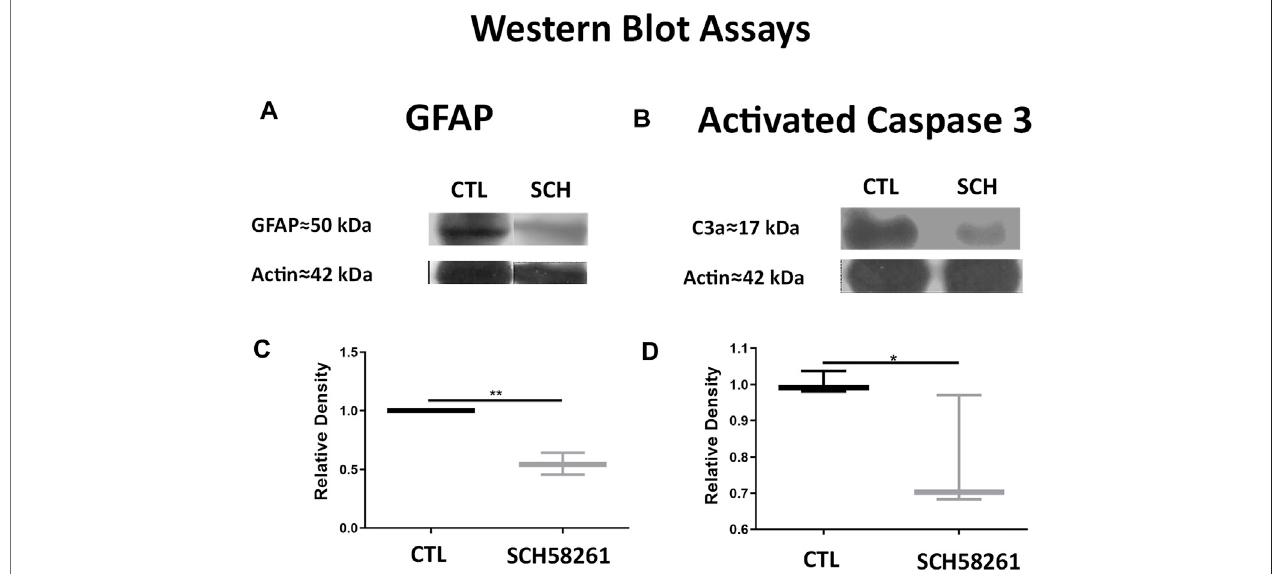
FIGURE 6 | Treatment with SCH58261 decreased levels of GFAP and activated caspase-3. (A) Representative Western blot (WB) for GFAP of CTL and SCH58261-treated eyes. (B) Representative Western blot for activated caspase-3 of CTL and SCH58261-treated eyes. (C) Quanti fi cations of GFAP WB of CTL and SCH58261-treated eyes (D) . Quanti fi cation of activated caspase-3 WB of CTL and SCH58261-treated eyes. Relative densities were normalized against CTL β -actin. Boxes represent 25 and 75 percentiles, whiskers represent minimum and maximum values, and transverse lines represent medians. Student ’ s t -test, * p < 0.05; ** p <